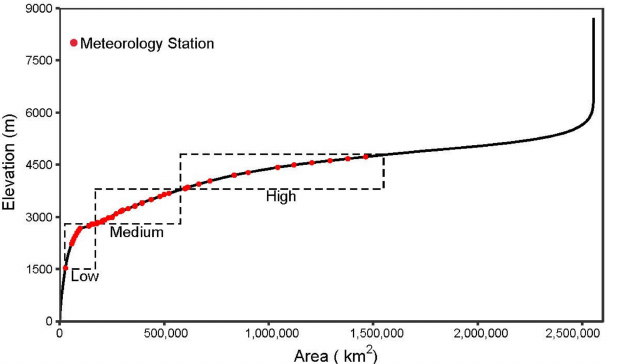
Figure 2. Area-elevation curve for QTP. The dashed boxes are the altitude and area range of the three elevation zones. The altitude of the low-elevation zone ranges from 1500 m to 2800 m (11 stations), the medium is 2800 m to 3800 m (22 stations), and the high is 3800 m to 4800 m (13